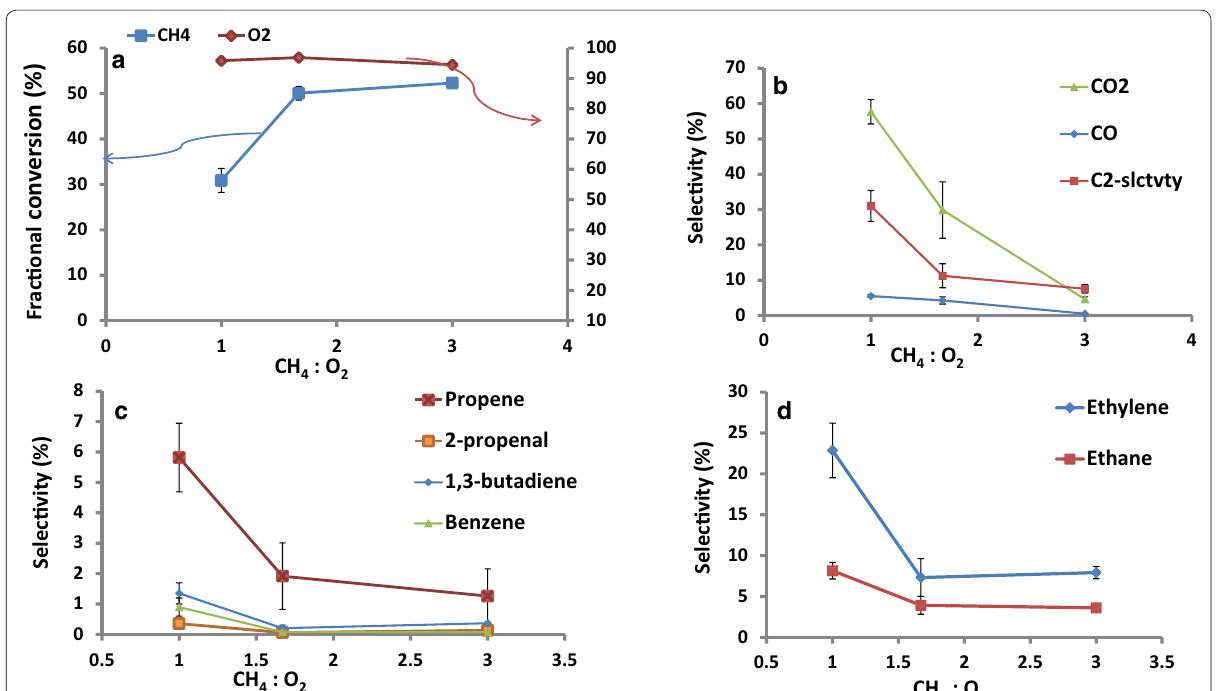
Fig. 4 Effect of methanol-to-oxygen ratio on ( a ) conversion of methane and oxygen, ( b ) selectivity of carbon oxides and total C 2 hydrocarbons, ( c ) selectivity of C 3 –C 6 hydrocarbons, and ( d ) selectivity of C 2 hydrocarbons under the experimental conditions: 650 ºC, 0.8 L/min, 10 g catalyst (2% iron